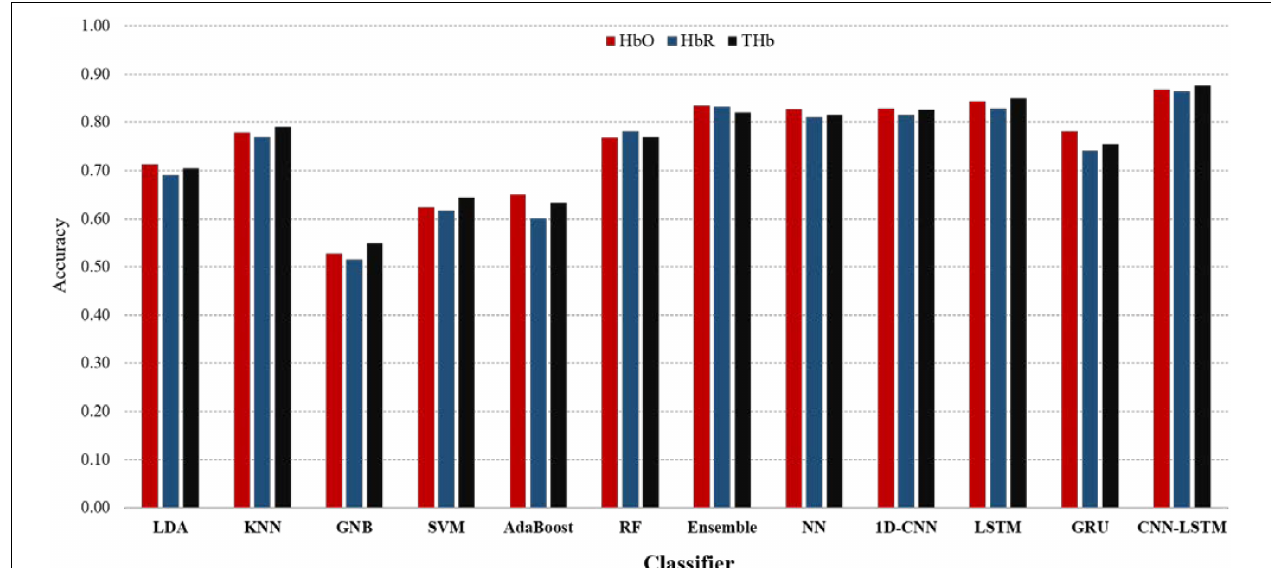
200 epochs training. LDA offered an elegant way to